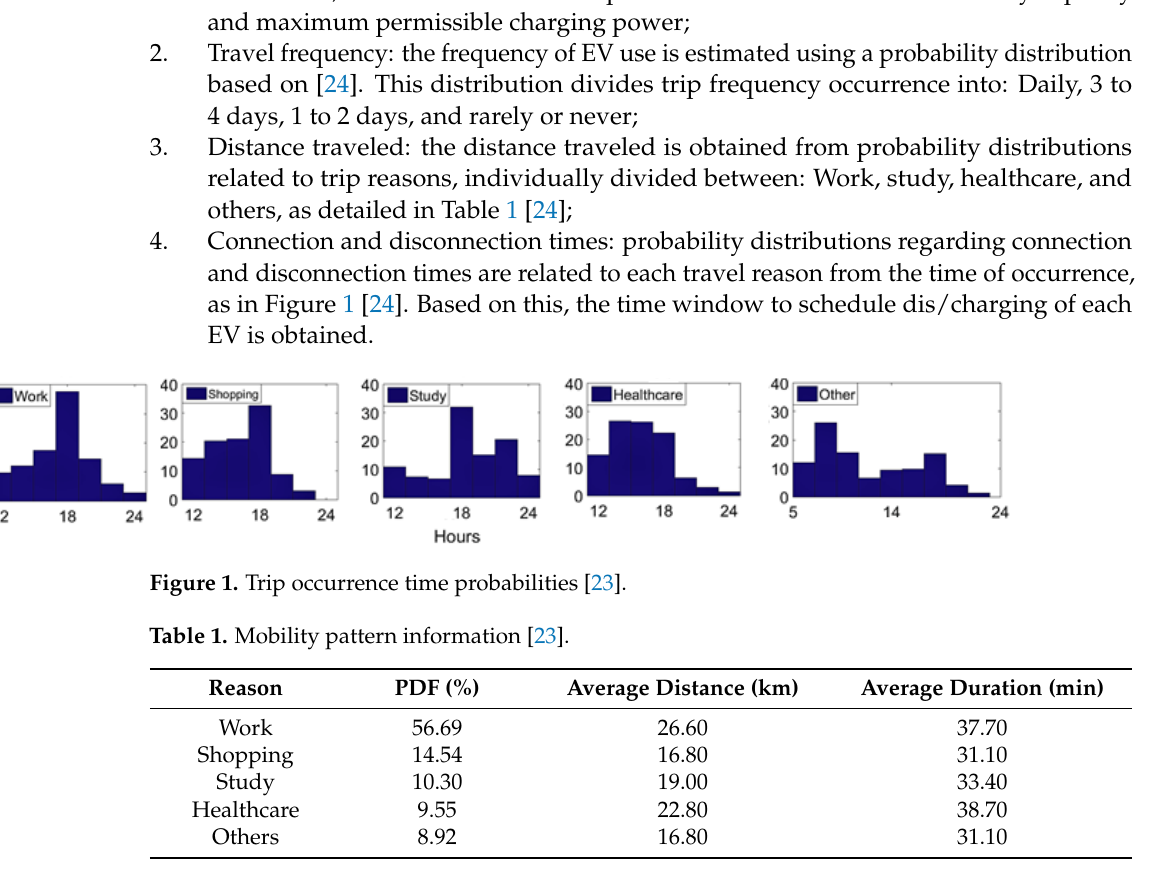
Table 1. Mobility pattern information [23].